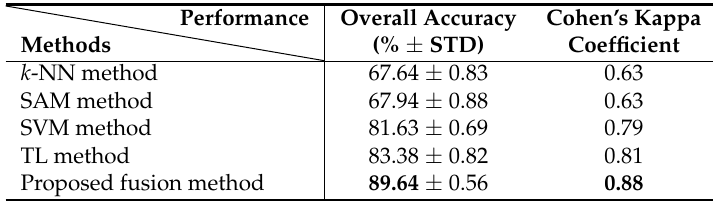
Figure 10. Classification results of ten tests, from left to right: k -NN, SAM, SVM, TL and the proposed method, AVIRIS 92AV3C dataset, 10% training set. Note: k -NN: The nearest neighbor classifier; SAM: The spectral angle mapping; SVM: The support vector machine; TL: The transfer learning method. Table 4. Comparison of averaged performance by 10 times of random sampling, AVIRIS 92AV3C dataset, 16 classes, 10% training